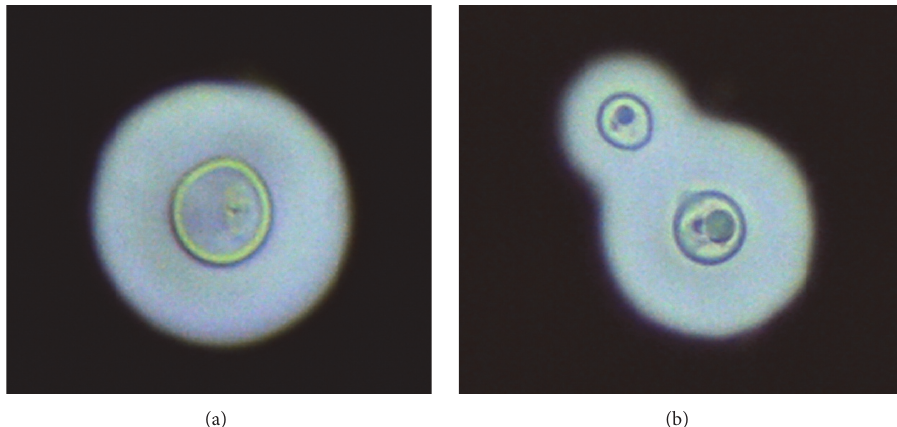
Figure 1: Microscopy of the Cryptococcus neoformans isolates in the CSF stained with India ink showing spherical (a) and budding yeasts (b) surrounded by a clear haloed zone ( ×